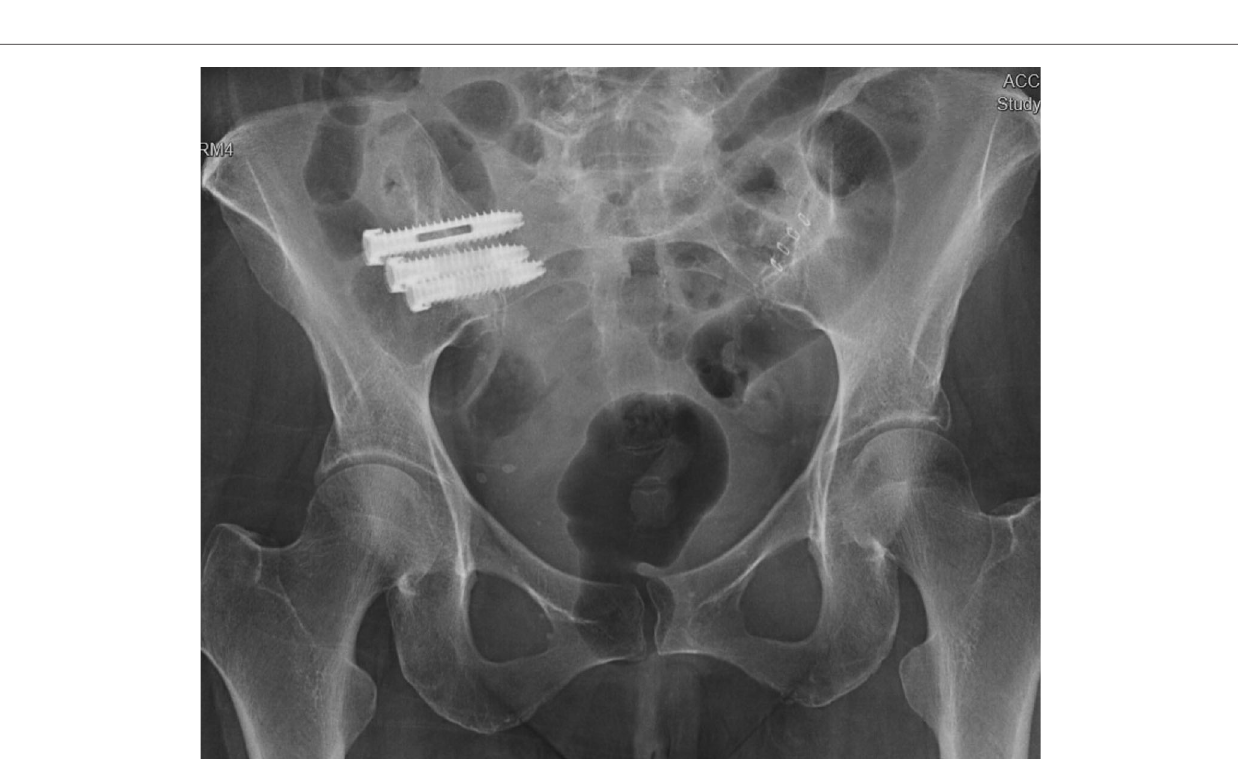
FIGURE 6 | Post-implantation X-rays demonstrating appropriate placement of the hydroxyapatite-coated titanium implants through the right SI joint (from (36), used with